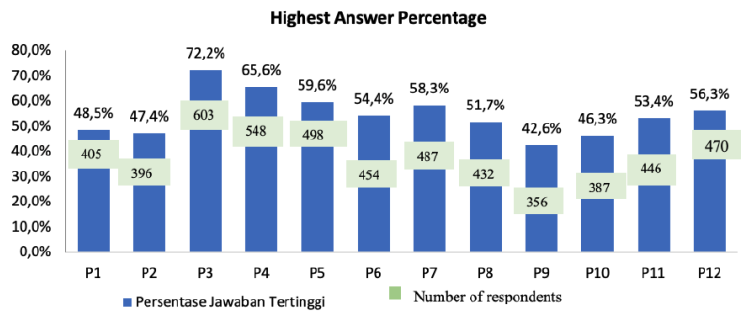
Figure 2: Percentage of Programs Required by Students/Graduates